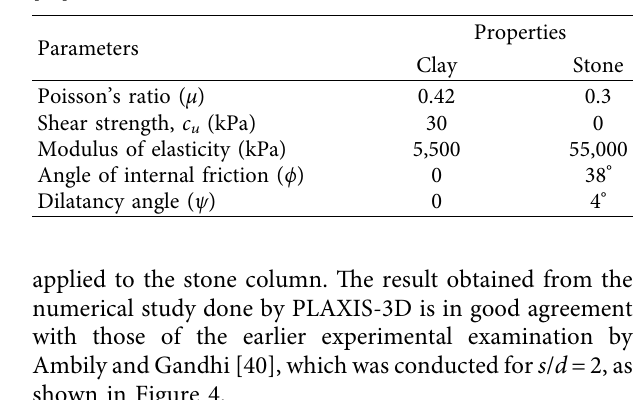
Table 1: Material’s properties as utilised by Ambily and Gandhi